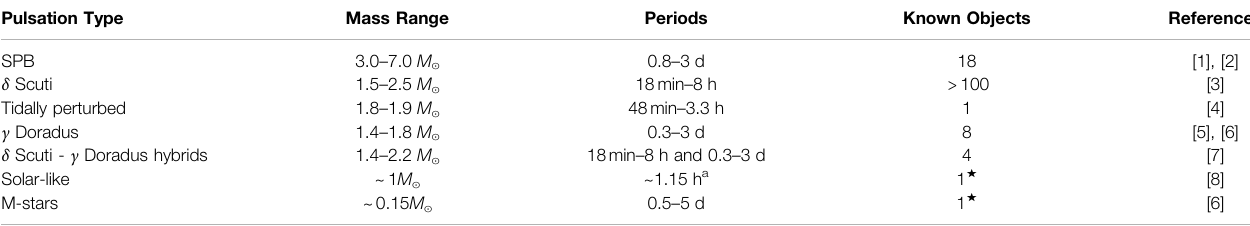
TABLE 1 | Types of known pre-main sequence pulsators and their properties (as of March 2022). Pulsation Type